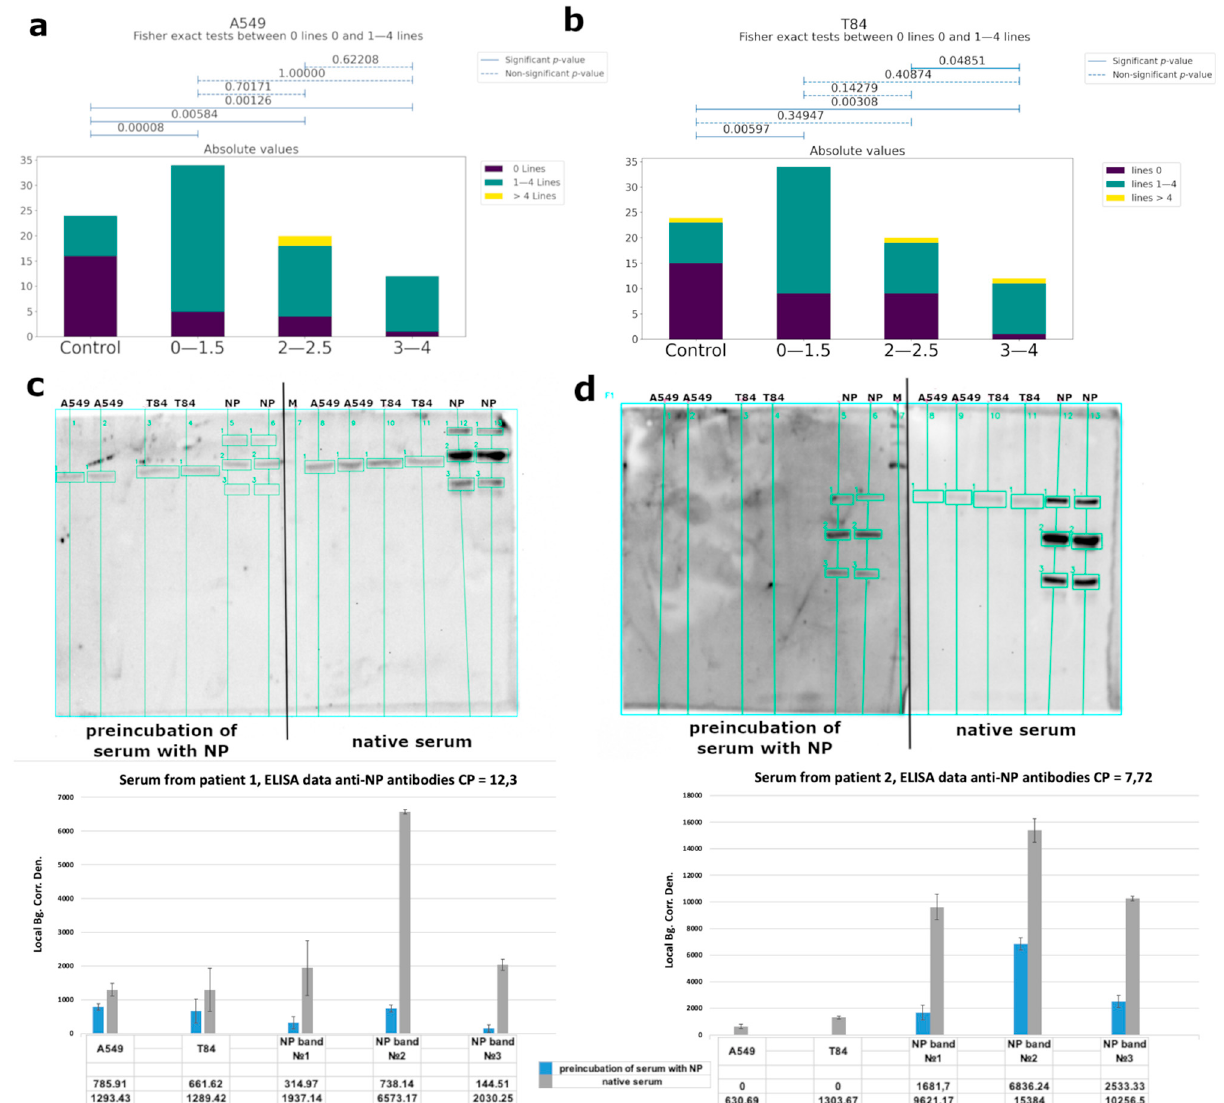
Figure 5. Analysis of the cross-reactive binding of IgG antibodies from the sera of patients with COVID-19 with linear epitopes of human proteins. Serum from healthy donors obtained before COVID-19 time was used as a control. ( a , b ) Correlations between the number of bands recognized by antibodies and groups of patients of different severity (according to CT data) for A549 cells and T84, respectively. ( c , d ) Analysis of the cross-reactivity of IgG from the serum before and after the separation of anti-NP specific antibodies from two different patients’ serum, respectively, with eukaryotic proteins by western blot and quantitative values of bands chemiluminescence calculated using the built-in software iBright Imaging Systems (ThermoFisher). The table shows the average signal intensity values. Local Bg. Corr. Den.—Local Background Correction Density—The Local Background Corrected Volume divided by the Area. Table 1. List of the identified proteins from eukaryotic cell lysates, which were recognized by anti- bodies from the COVID-19 patient sera.